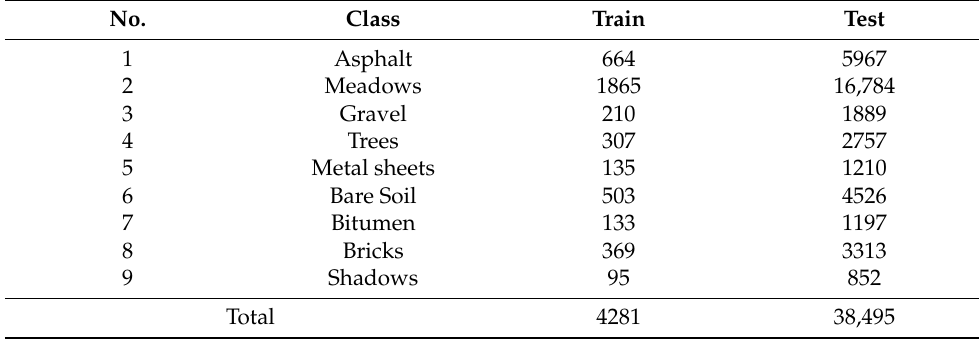
Table 2. Land cover class information for the UP dataset.